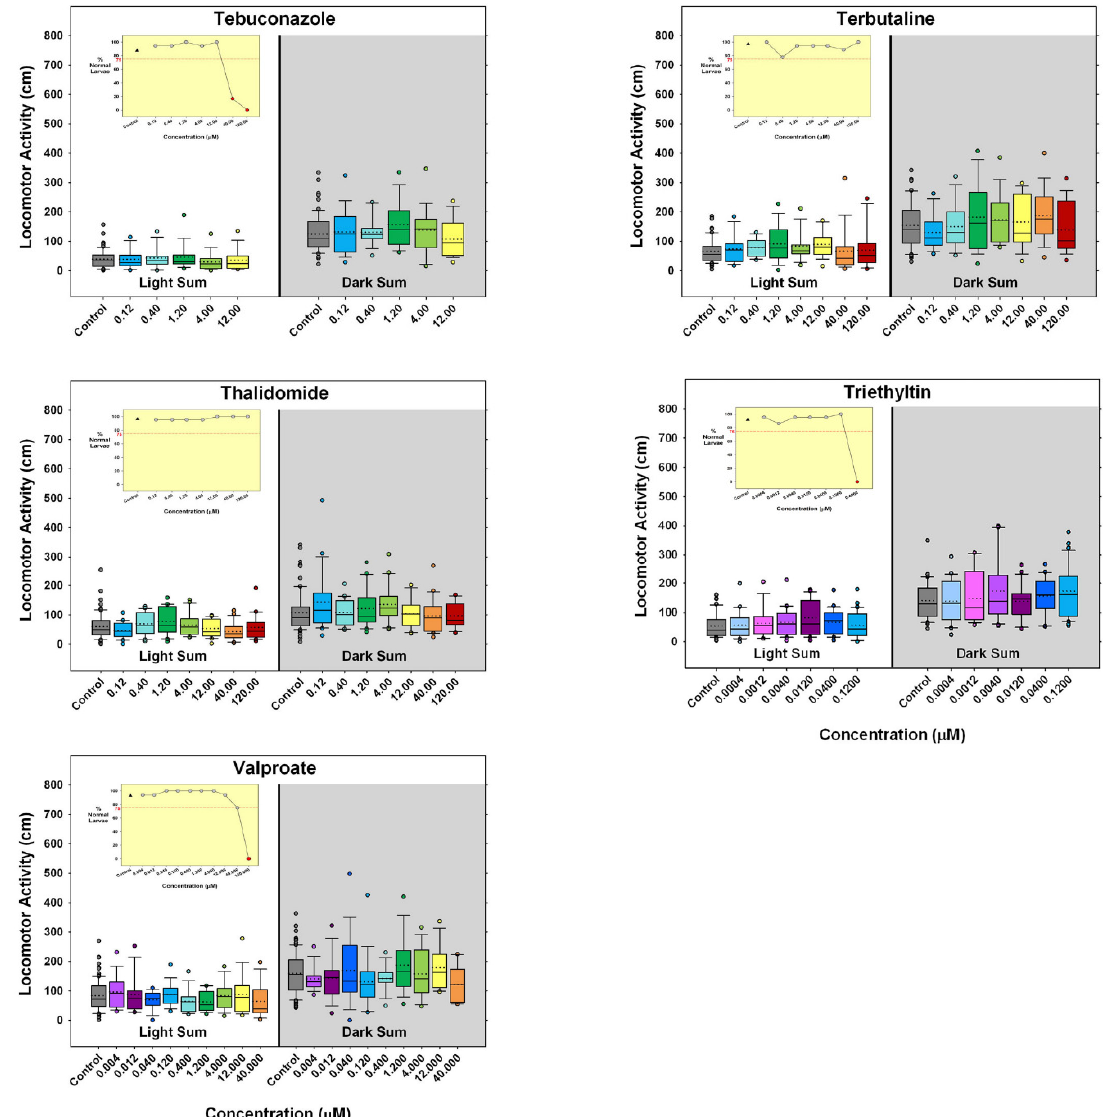
Figure 5. Behavioral Concentration Response for Each Chemical Presented in a Box Plot with Developmental Toxicity as a Line Graph in the Inset. Box plots show locomotor activity for both the Light and Dark (gray background) periods. The box represents the interquartile range (middle 50%), the top of the box to the top error bar is the upper quartile (75th percentile) while the bottom of the box to lower error bar is the lower quartile (25th percentile). The solid line in the middle of the box is the median and the dotted line in the middle of the box is the mean. The top whisker/error bar indicates the maximum and the bottom whisker/error bar indicates the minimum. The developmental toxicity inset shows the percent of normal larvae for the control and for each concentration. The dotted red line is the 75% line and concentration groups that fall below are considered developmentally toxic and not included in behavioral analyses. The triangle represents control data, and the gray circles indicate results at each concentration. All concentrations are in micromolar ( μ M).